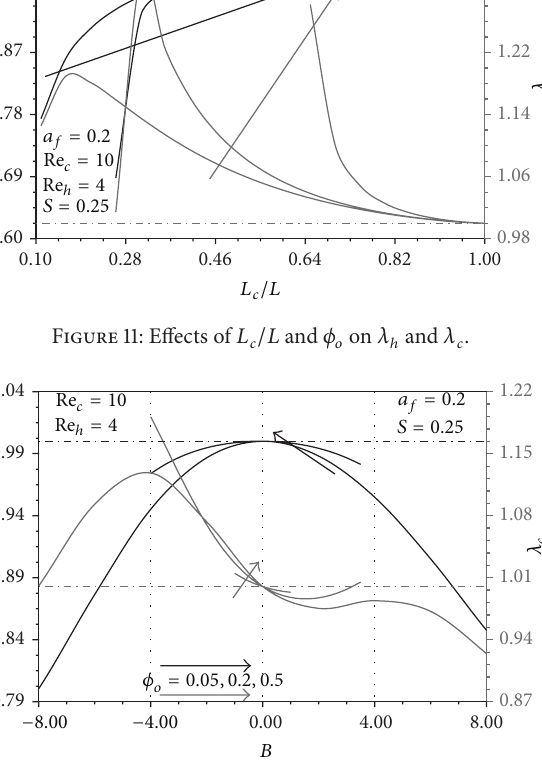
Figure 12: Effects of 𝐵 and 𝜙 𝑜 on 𝜆 ℎ and 𝜆 𝑐 .